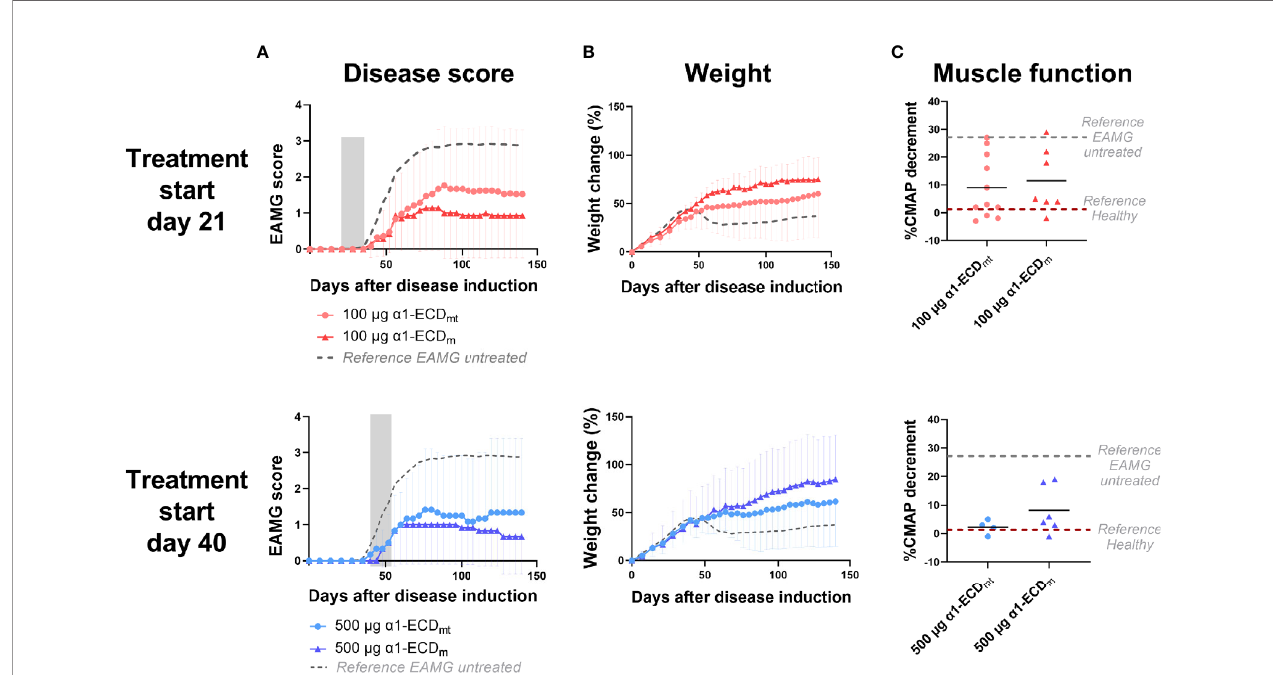
FIGURE 7 | a 1-ECD mt and a 1-ECD m display comparable treatment ef fi cacies. EAMG rats received a 1-ECD mt or a 1-ECD m by intravenous injection on twelve consecutive days from day 21 (100 m g; N = 14 for ECD mt and N = 7 for a 1-ECD m ) or day 40 (500 m g; N = 6 for each group) of the experiment. (A) Average EAMG scores (± SD); the grey bar indicates the treatment period. Circles correspond to a 1-ECD mt and triangles correspond to a 1-ECD m , while the dotted line represents untreated rats for reference. (B) Average percentage of body weight change (± SD). (C) CMAP decrement: each symbol corresponds to one rat and the bar shows the mean value. In (C) dotted lines represent untreated EAMG rats and healthy rats for